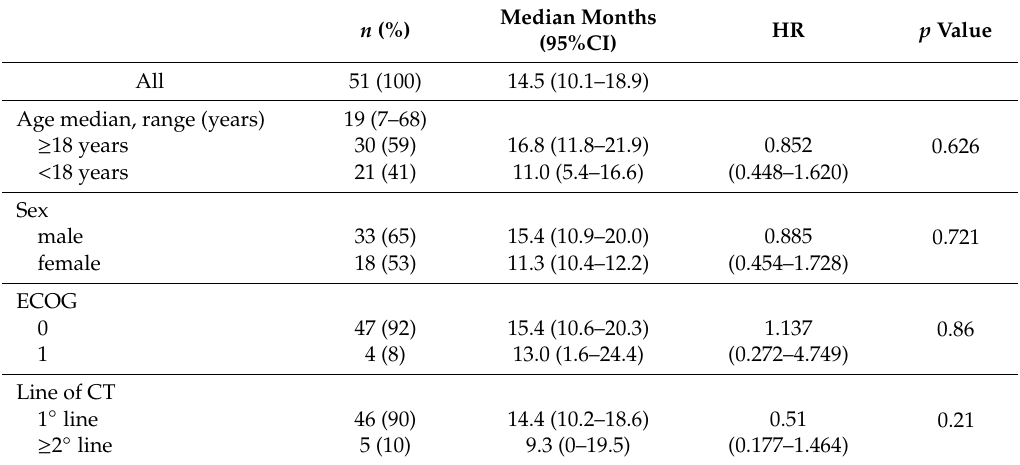
Figure 2. ( A ) Overall survival (OS) in 51 patients treated with high dose ifosfamide; ( B ) OS according with surgical, second complete remission (CR2) status. Table 5. Univariate analysis for overall survival (OS) from HDIFO start in patients affected by relapsed osteosarcoma.